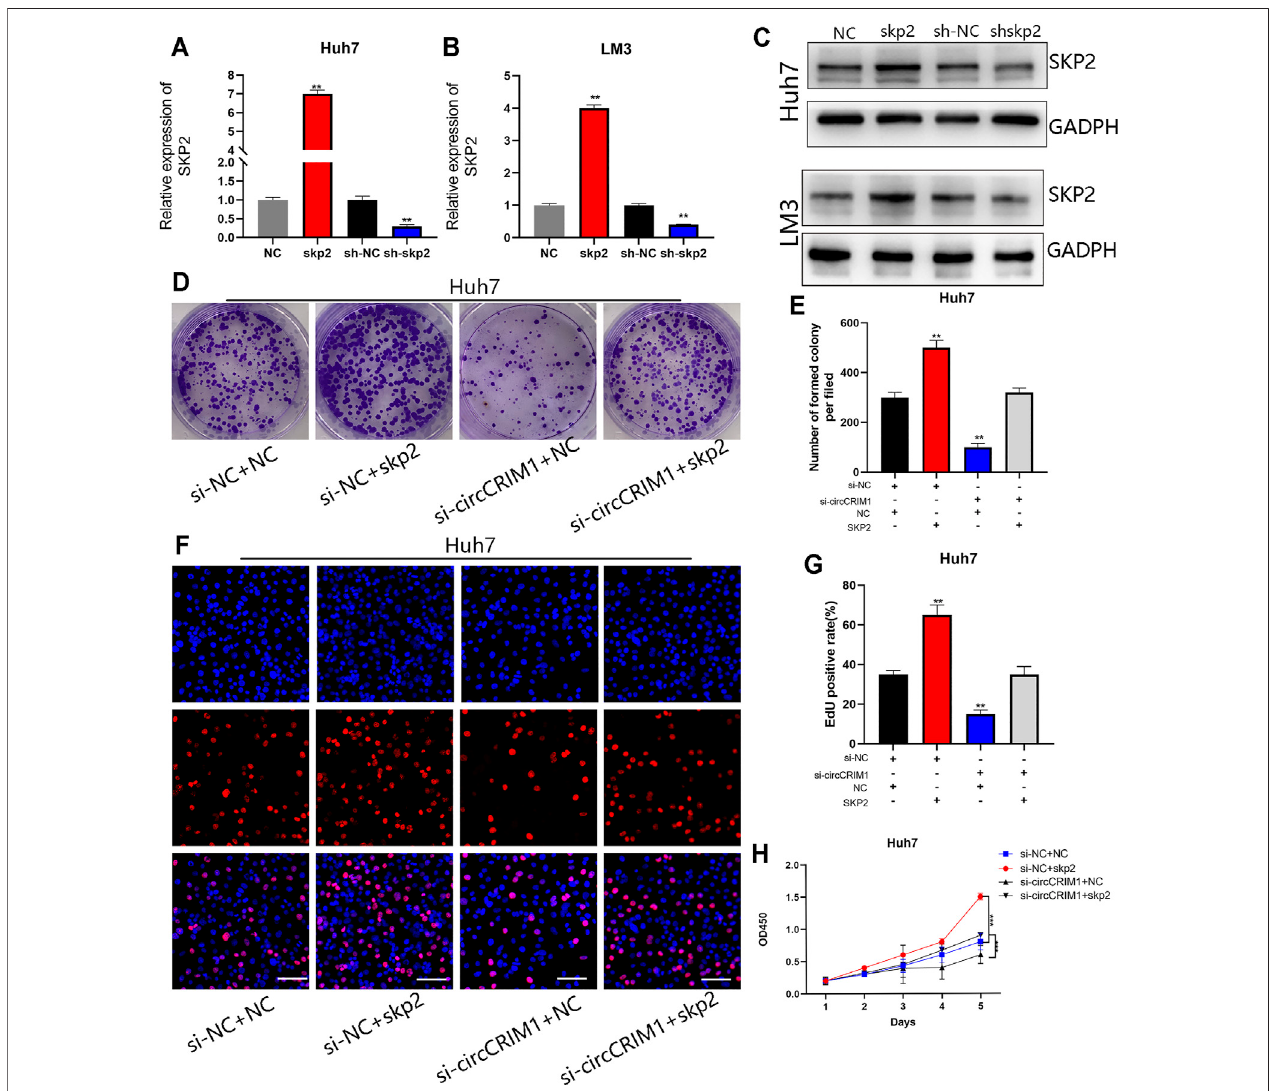
FIGURE7| CircCRIM1promotesHCCproliferationandangiogenesisviamiR-378a-3p/SKP2axis. (A – C) Transfectionef fi ciencyofshSKP2,shNC,SKP2,andNC in LM3 and Huh7 cells was veri fi ed by RT-qPCRand western blotting. (D,E) Colony formation assays were performed toevaluate cell proliferation. (F,G) EdU assays for HCC cells were performed to evaluate cell proliferation. Scale bar, 50 μ m. (H) Cellular growth curves were evaluated by CCK-8 assays in Huh7 cells. All data are presented as the means ± SD of three independent experiments. * p < 0.05, ** p < 0.01, *** p < 0.001, and **** p < 0.0001.